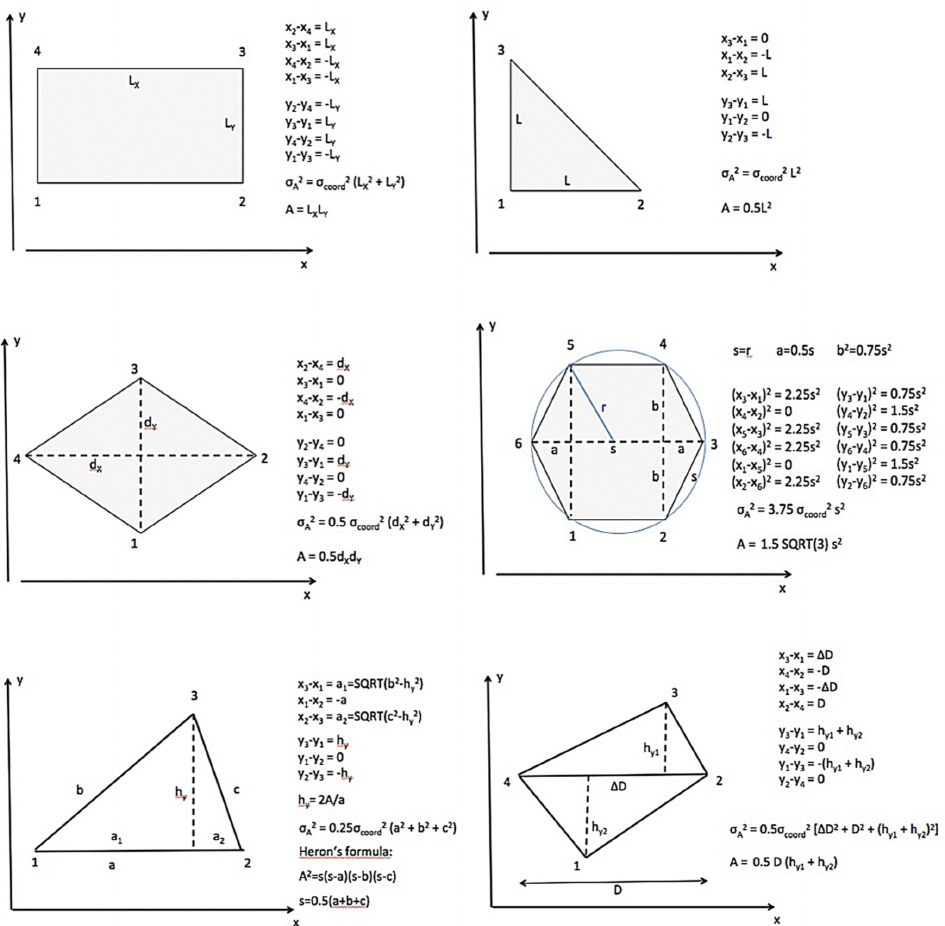
Figure 2. Application of Eq. (12) to different geometrical figures: rectangle, equal-sided right triangle, rhombus, regular hexagon, triangle, and